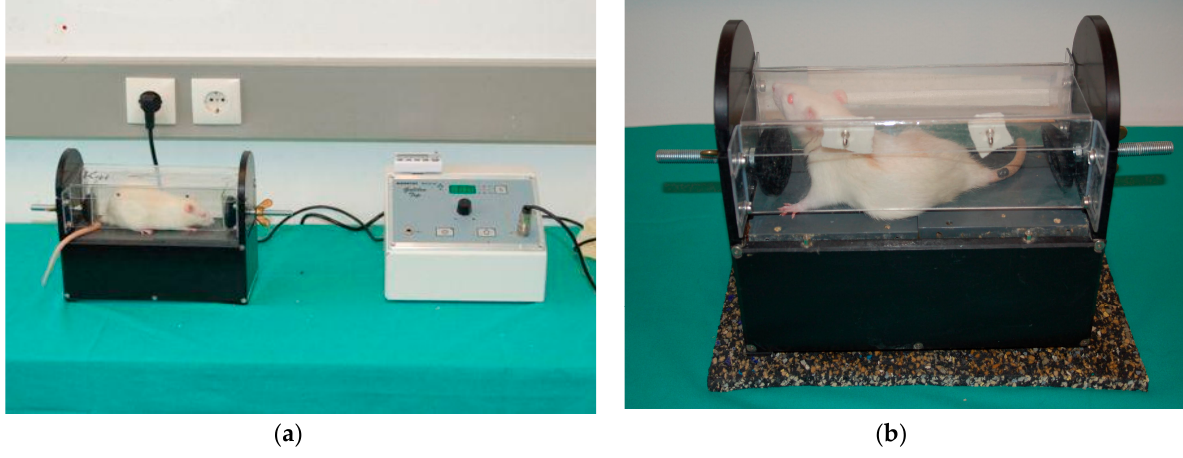
Figure 3. ( a , b ) Whole-body vibration (WBV) therapy. The WBV therapy was applied by the custom- made Galileo-system device. Pre-injury conditioning started 2 weeks prior to SCI and post-injury treatment started on day 7, 14, or 28 after SCI. Every WBV session comprised five sequential trials, each consisting of 1-min 15-Hz vibration followed by 2 min at 30 Hz [28].